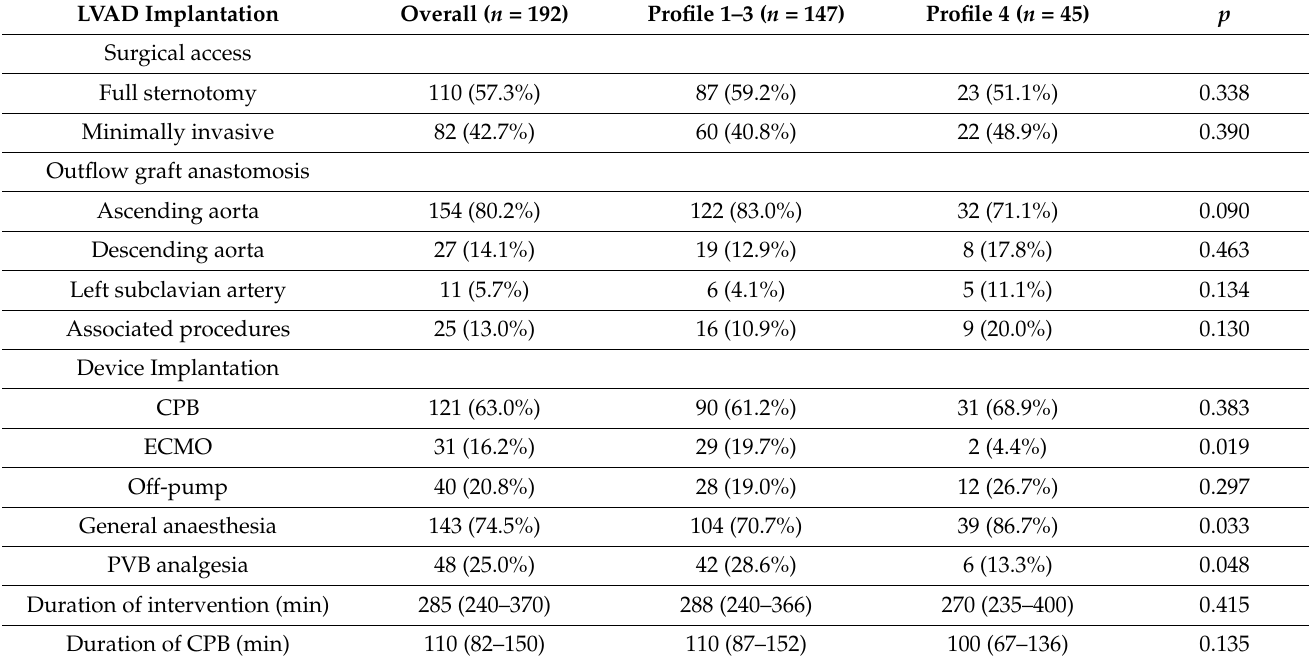
Table 2. LVAD implantation characteristics of overall ( n = 192), INTERMACS Profile 1–3 ( n = 147) and Profile 4 ( n = 45) patients.